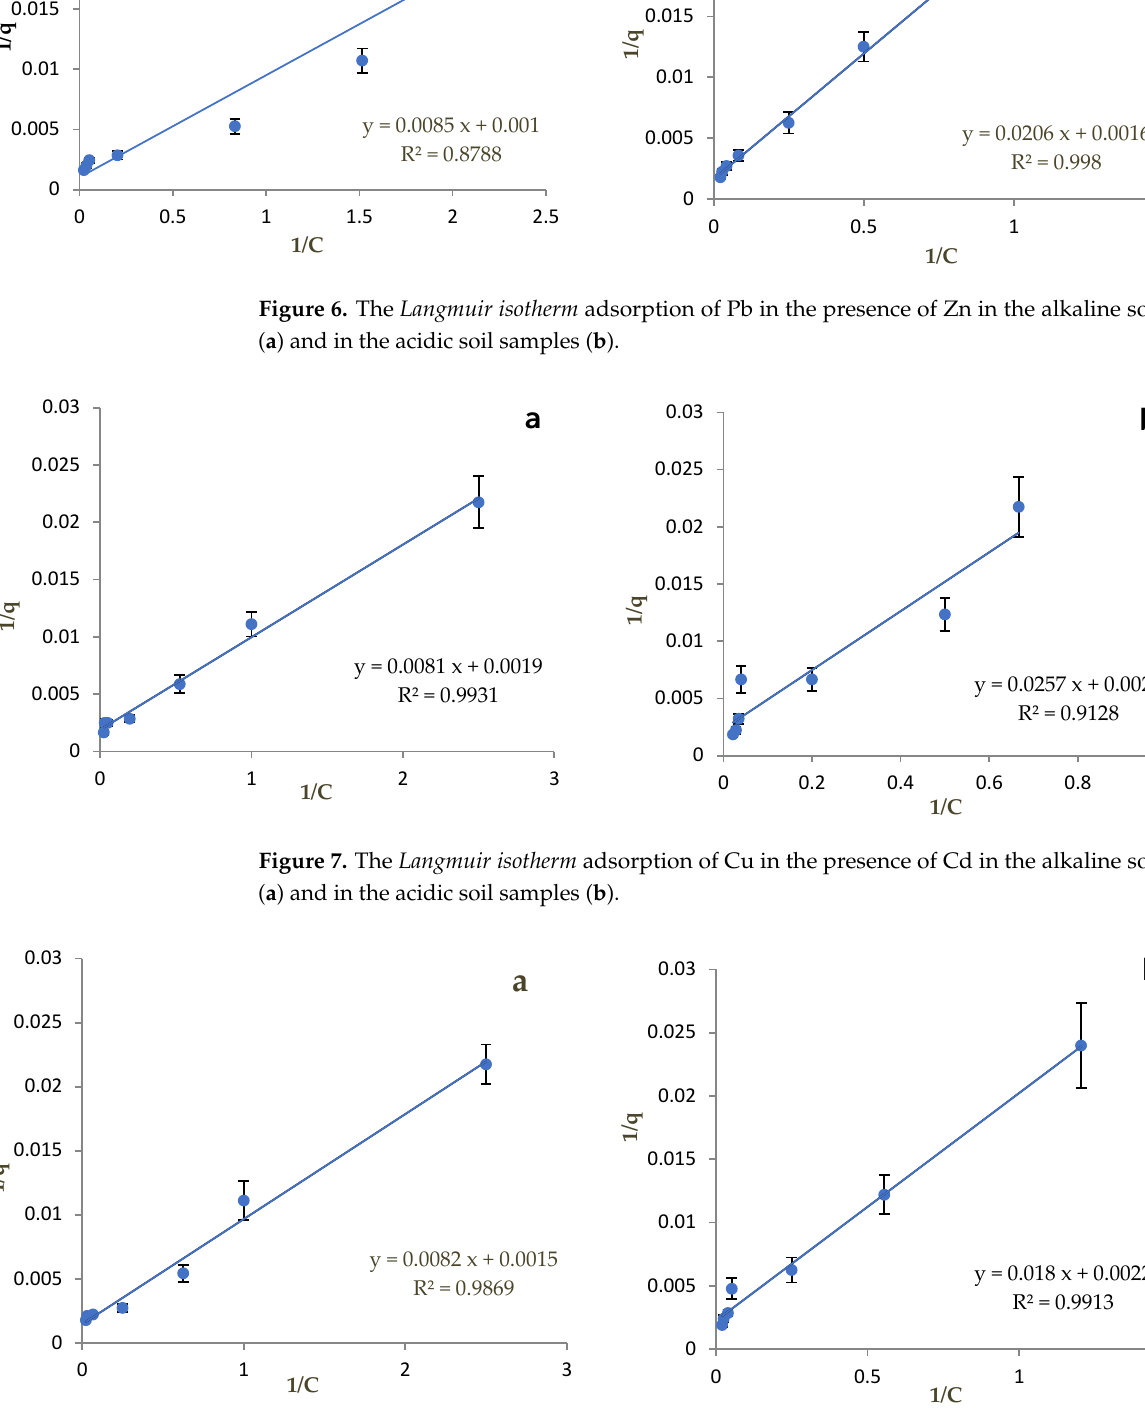
Figure 8. The Langmuir isotherm adsorption of Cd in the presence of Cu in the alkaline soil sample ( a ) and in the acidic soil samples ( b ).